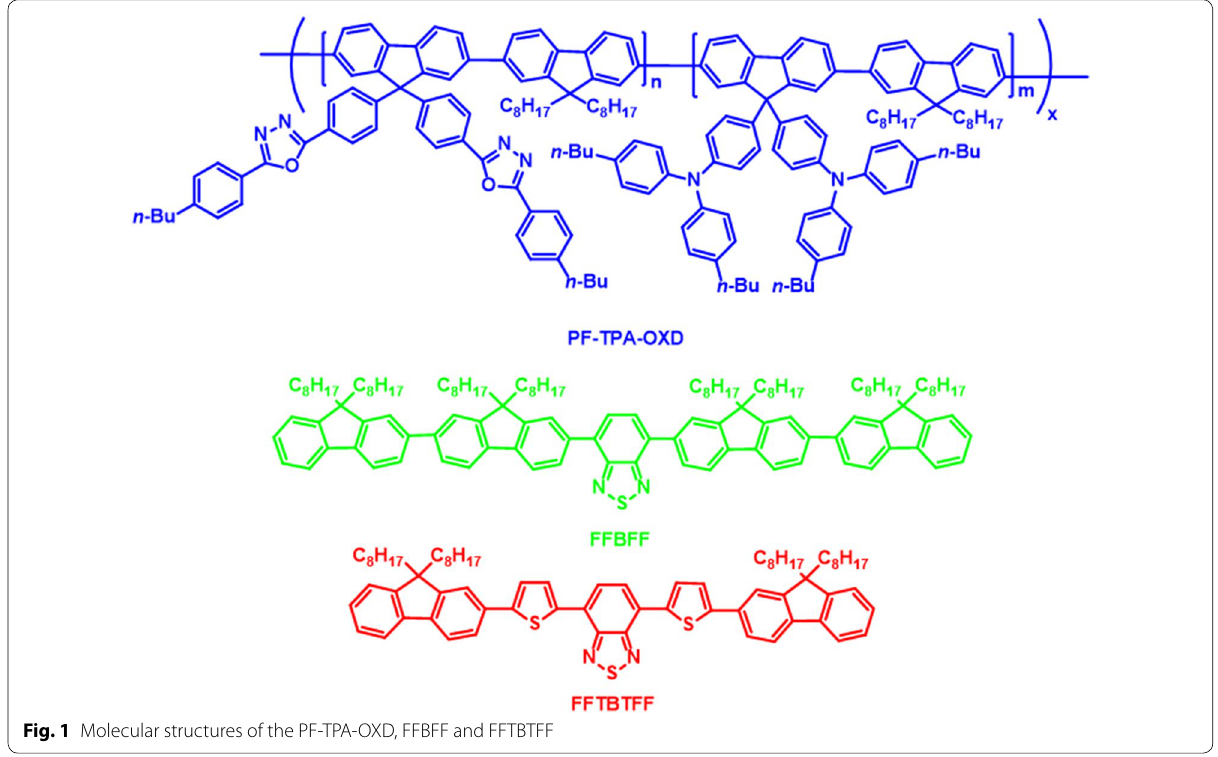
Fig. 1 Molecular structures of the PF-TPA-OXD, FFBFF and FFTBTFF